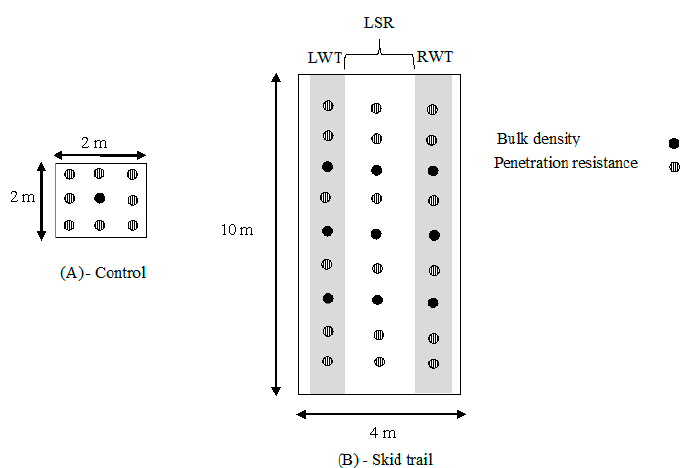
Figure 1. Sample plots on control ( A ) and skid trail ( B ), and bulk density and penetration resistance on plot, LWT: Left wheel track, RWT: Right wheel track, LSR: Log skidded route. On each skid-trail sample, 9 soil core samples (3 samples on the left wheel tracks, 3 samples on the right wheel tracks, and three core samples on log skidded routes, between the two wheel tracks) were taken to measure soil bulk density. Also, one core sample from the center of the control plot was taken. In total, 30 soil core samples were taken from wheel tracks, 15 soil core samples from log skidded routes, and 15 soil core samples from undisturbed (control) sites.